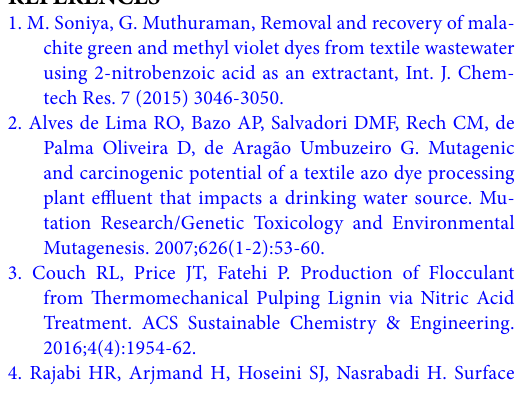
There are no conflicts to